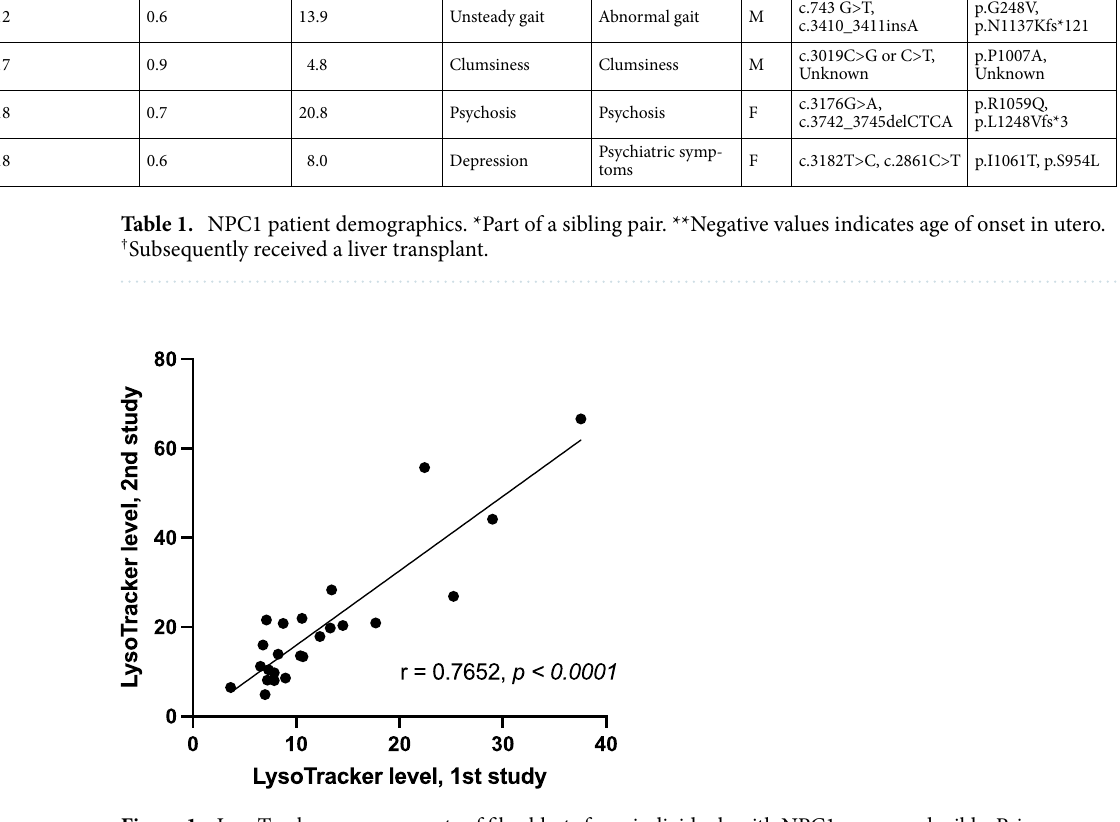
Figure 1. LysoTracker measurements of fibroblasts from individuals with NPC1 are reproducible. Primary fibroblast cell lines established from 24 individuals with NPC1 were previously stained with LysoTracker, and these LysoTracker levels were measured by FACS for each cell line 42 . Several years later, fibroblasts from these 24 cell lines were again subjected to the same LysoTracker staining protocol. Measurements from both studies were paired for each patient, and correlation analysis showed significant correlation of the paired measurements for these NPC1 cell lines (Spearman r = 0.7652, p < 0.0001). Line was calculated using simple linear